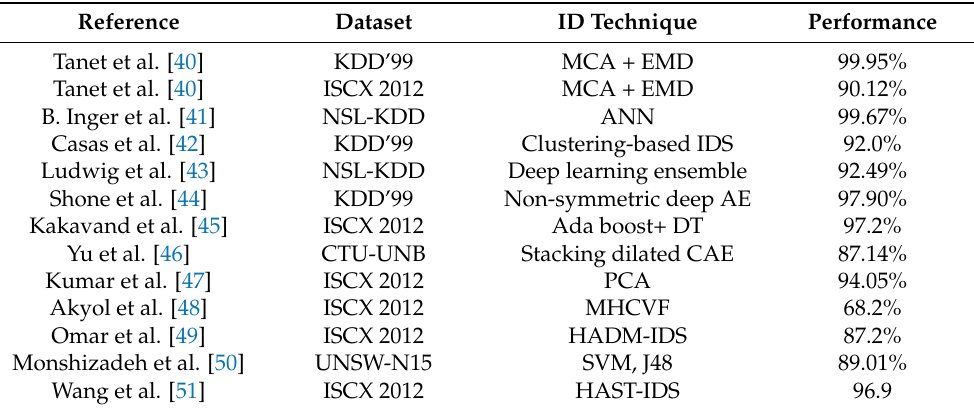
Table 1. Summary of different approaches in the ID